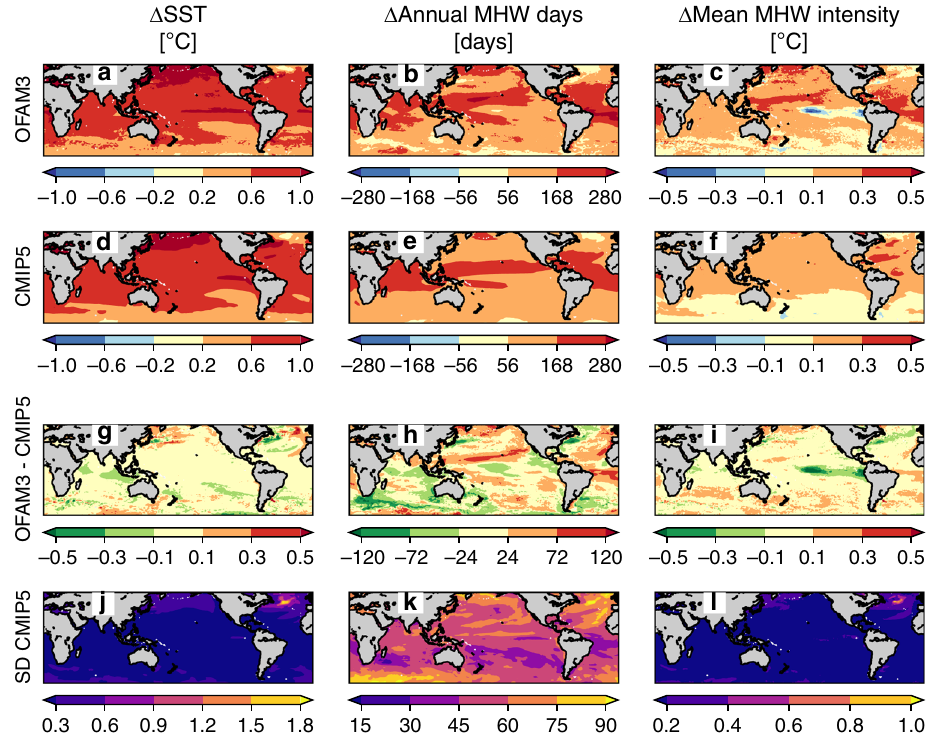
Fig. 4 Projected changes in sea surface temperature and marine heatwaves. Spatial distributions of projected changes (2021 – 2050 minus 1982 – 2018) in mean sea surface temperature (SST), annual marine heatwave (MHW) days, and mean MHW intensity based on a – c a high-resolution ocean model (OFAM3) and d – f the multi-model mean product of 23 global climate models (CMIP5) under the Representative Concentration Pathway 8.5, g – i the difference between the two products (OFAM3 minus CMIP5), and j – l the inter-model spread of the CMIP5 models, as determined by standard